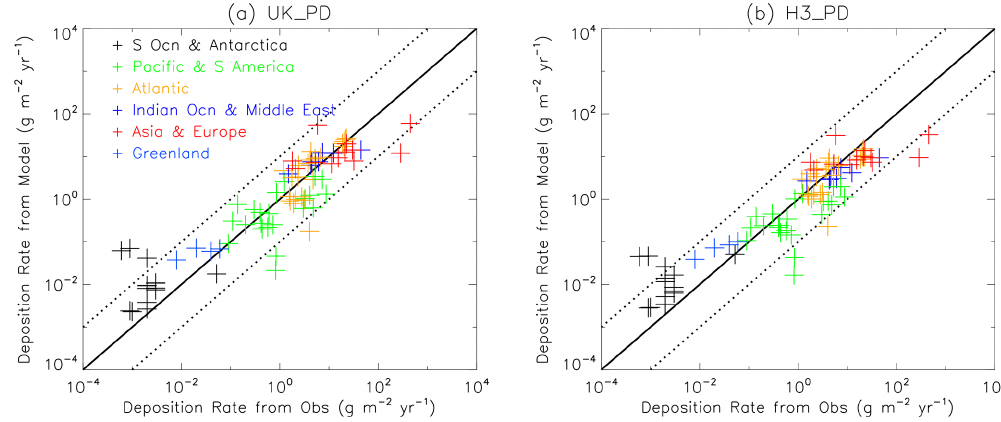
5.6 Drivers of UKESM1–HadGEM3-GC3.1